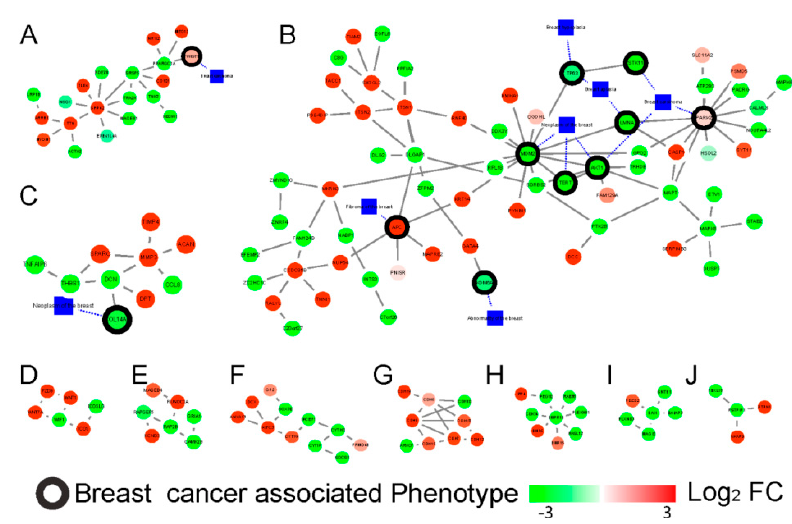
Figure 7. The differentially expressed networks regulated by bufadienolide-like chemicals, and generated by the PhenomeScape plug. Sub-networks linked to breast cancer, RNA splicing (2.00 × 10 − 3 ) ( A ), apoptotic process (2.00 × 10 − 3 ) ( B ), extracellular matrix organization (1.00 × 10 − 3 ) ( C ), canonical Wnt signaling pathway (2.20 × 10 − 2 ) ( D ), synaptic transmission (1.40 × 10 − 2 ) ( E ), negative regulation of JAK-STAT (Janus kinase/signal transducers and activators of transcription) cascade (4.20 × 10 − 2 ) ( F ), adherens junction organization (3.80 × 10 − 2 ) ( G ), BMP signaling pathway (4.10 × 10 − 2 ) ( H ), negative regulation of cell migration (1.30 × 10 − 2 ) ( I ), and activation of signaling protein activity involved in the unfolded protein response (1.90 × 10 − 2 ) ( J ). The fold change of the proteins is shown by the node color, and breast cancer-associated phenotype annotated proteins were used to generate the sub-networks and are shown with a black border.